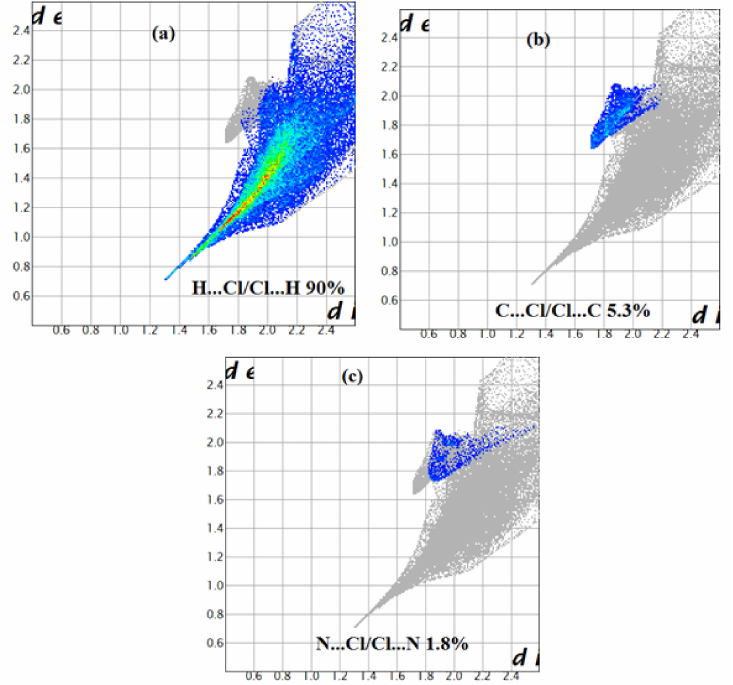
Figure 10. Decomposed fingerprint plots of the major contacts around the [CoCl 4 ] 2 − of compound ( 2 ). ( a – c ) represent H . . . Cl, C . . . Cl and N . . . Cl contacts,